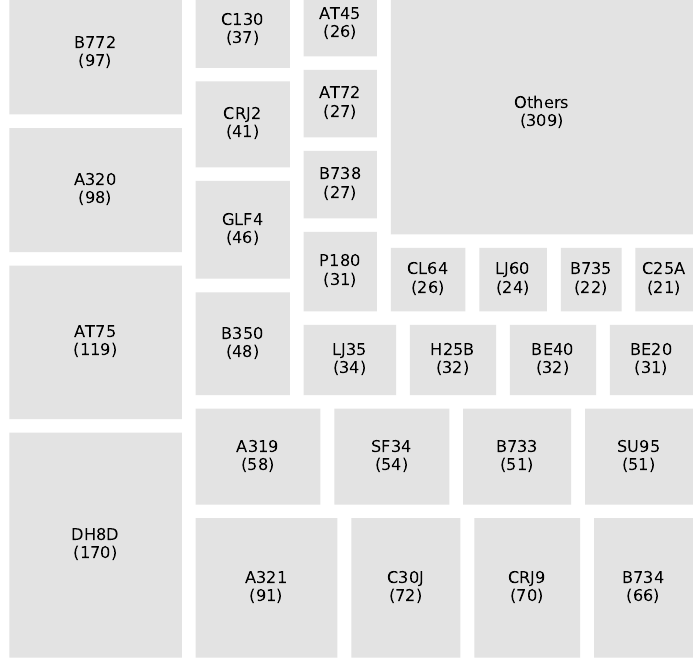
Figure 5. Aircraft with meteorological capabilities enabled. Aircraft typecode and number of aircraft are shown. The total number of aircraft shown is 1811. Only typecodes with more than 20 aircraft are listed in